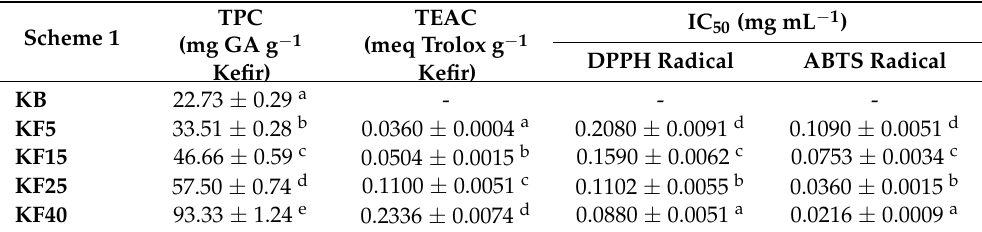
Table 4. Total phenolic content and antioxidant activity of kefir enriched with CSU2 . Each measure- ment was carried out in triplicate and data expressed as means ( ± SD).